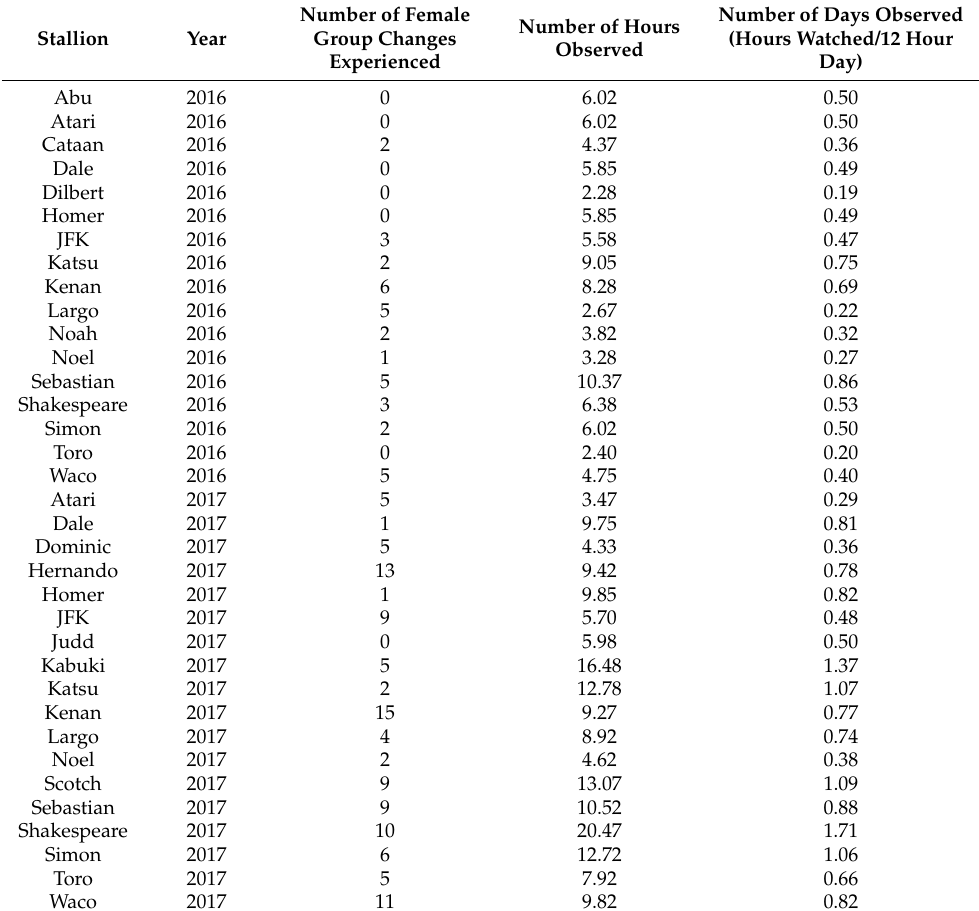
Table A1. The number of female group changes experienced by all stallions and the time stallions were observed over the course of the study on Shackleford Banks, North Carolina.